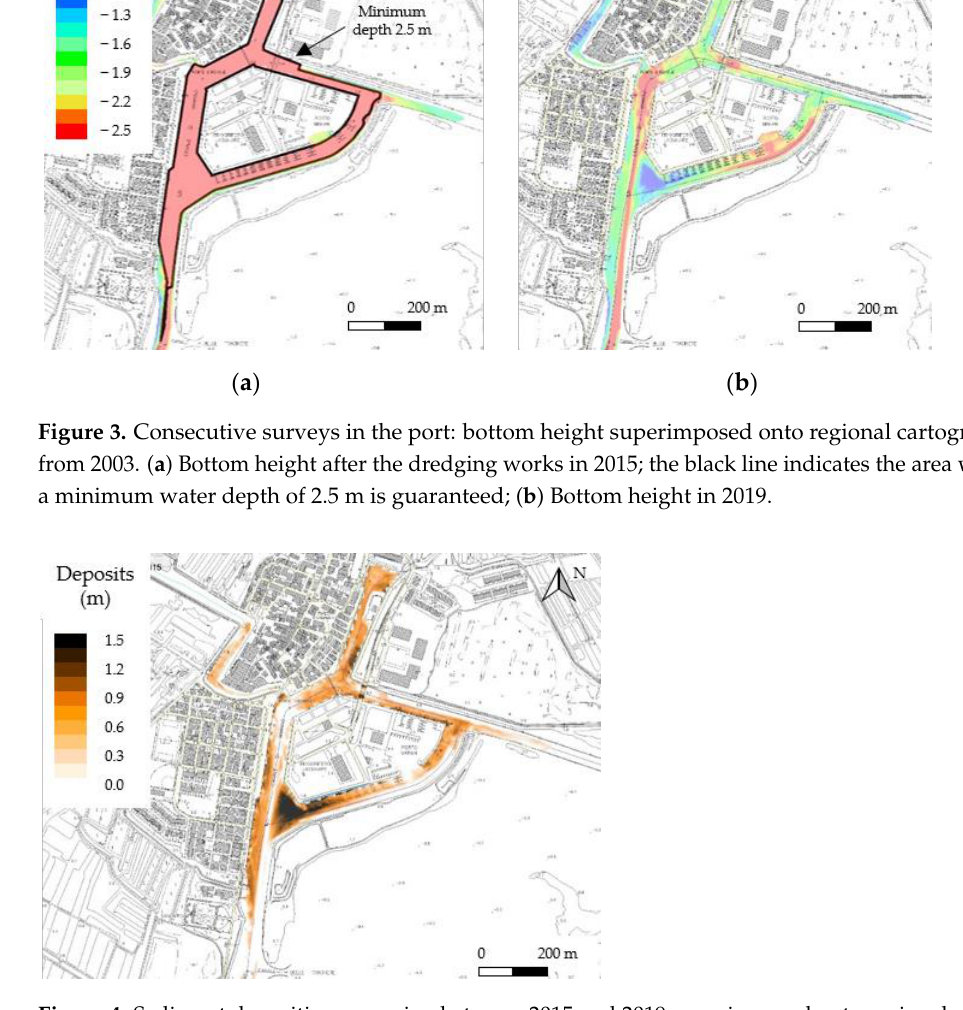
Figure 4. Sediment deposition occurring between 2015 and 2019 superimposed onto regional cartography from 2003.